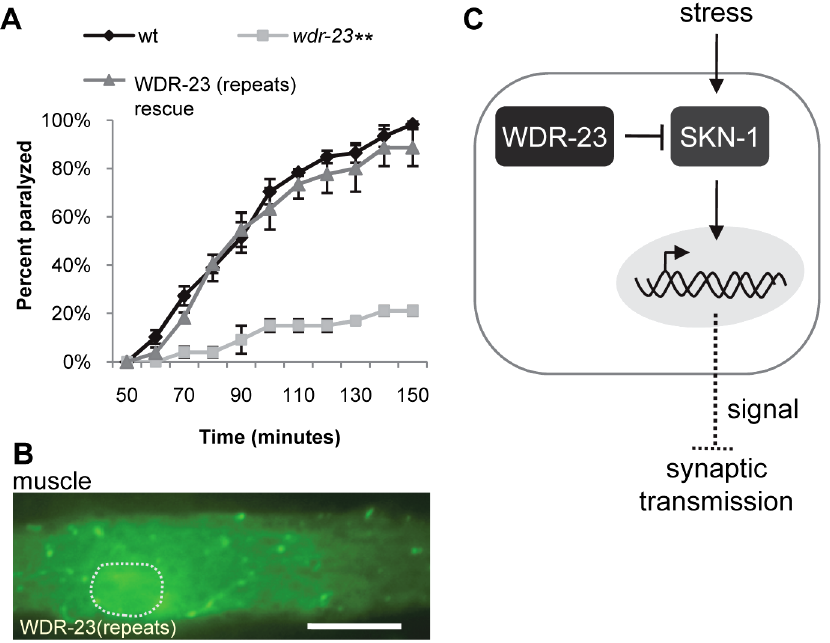
Figure 6. The WD40 repeat domains are sufficient for WDR-23 function. (A) Rates of worm paralysis of the indicated strains when exposed to 1.0 mM aldicarb. WDR-23(repeats) rescue denotes wdr-23 mutants expressing transgenes carrying a wdr-23 variant that only contains the seven WD40 repeats driven by the endogenous wdr-23 promoter. (B) WDR-23(repeat) tagged to GFP and expressed in muscle. Dotted circle denotes nucleus. (Scale bar represents 10 m m; Error bars indicate 6 SEM. ** p , 0.01.) (C) Model for SKN-1 regulation of synaptic function. In this model, WDR-23 inhibits SKN-1. Activation of SKN-1 in the intestine, either genetically through loss of wdr-23 or through environmental stress such as arsenite, increases transcription of target genes and may promote the release of a diffusible factor or factors. Endocrine signaling reduces synaptic vesicle and dense core vesicle release, resulting in decreased neurotransmission at neuromuscular junctions.